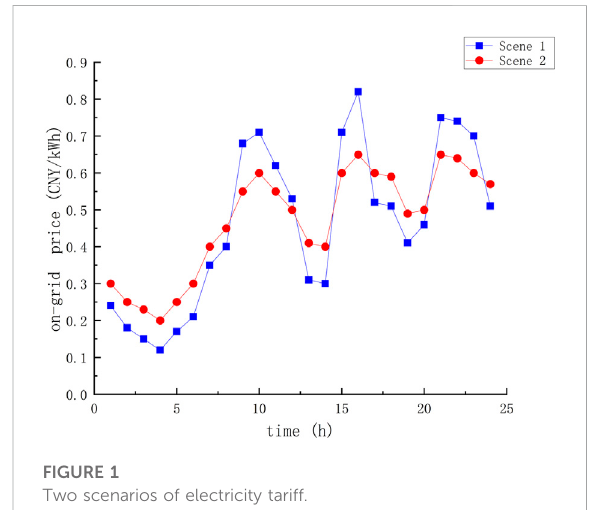
FIGURE 1 Two scenarios of electricity tariff.